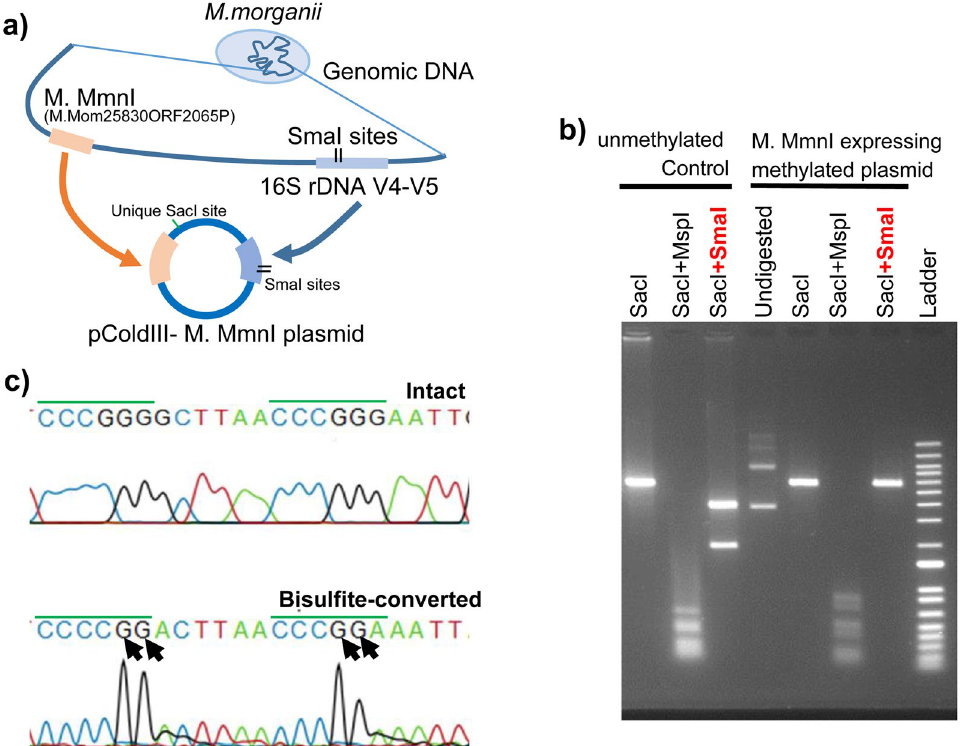
Figure 3. M. MmnI is responsible for four methylated residues at two consecutive SmaI sites within a palindrome-like structure. ( a ) Graphical scheme of pColdIII-M. MmnI (renamed from M.Mom25830ORF2065P) plasmid construction. ( b ) Restriction digestion of the pColdIII-M. MmnI plasmid evaluated via agarose gel electrophoresis. MspI and SmaI were used, where the plasmid contained 37 CCGG